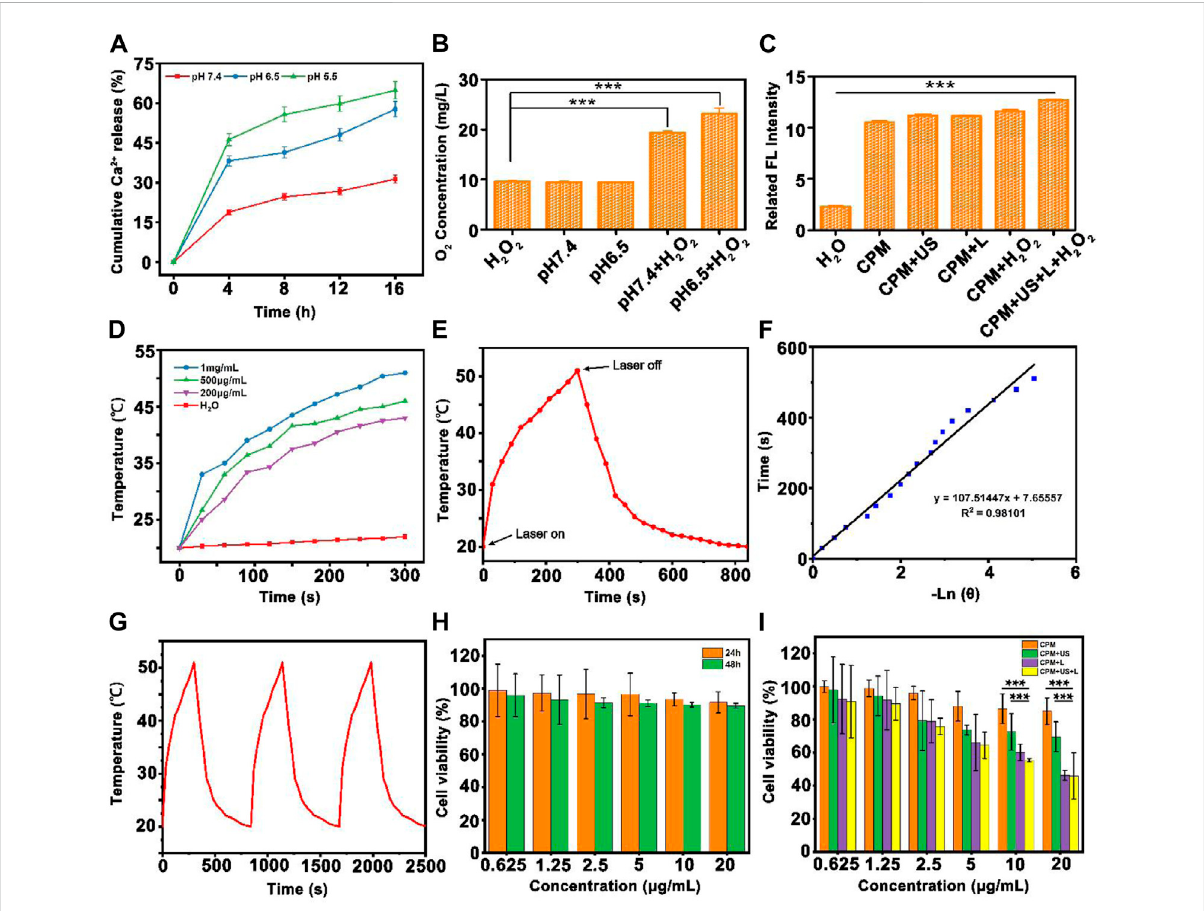
FIGURE 2 ThephysicochemicalcharacterizationofCPMNPs. (A) Time-dependentreleasepro fi lesofCa 2+ fromCPMNPsinPBSatdifferentpHvalues5.5, 6.5, and 7.4. The release percentages were calculated as the amount of release of Ca 2+ from CPM NPs/the total amount of Ca 2+ in CPM NPs. (B) The oxygenconcentrationsproducedbyCPMNPsatdifferentpHvalues inH 2 O 2 solution (100 μ M). (C) SOSG fl uorescenceintensities ofmaterialsunder different conditions. (D) Heating curves of different concentrations of CPM NPs under 1,064 nm laser irradiation. (E) Temperature record of CPMNPs(1 mg ml − 1 )underlaserirradiation. (F) Linear-timedataversus-ln( θ )obtainedfromthecoolingperiodofNIRlaseroff. (G) Thephotothermal conversion cyclingtestofCPMNPs(1 mg ml − 1 )duringthreelaseron/offcycles. (H) Viabilityof293Tafterbeingtreatedwithdifferentconcentrations of CPM NPs for 24 and 48 h. (I) Cell survival rate of 4T1 cells after being treated by different treatment